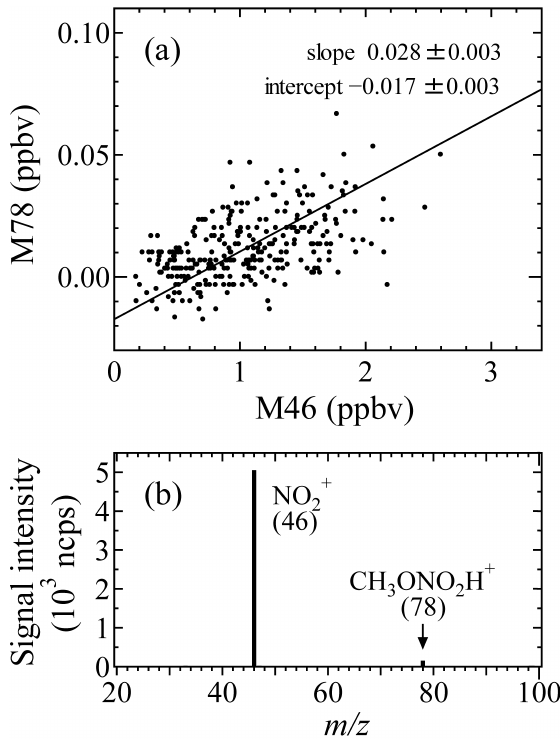
campaign. A best-fit line obtained by the RMA regression method is shown as a solid line. (b) A reference mass spectrum of methyl